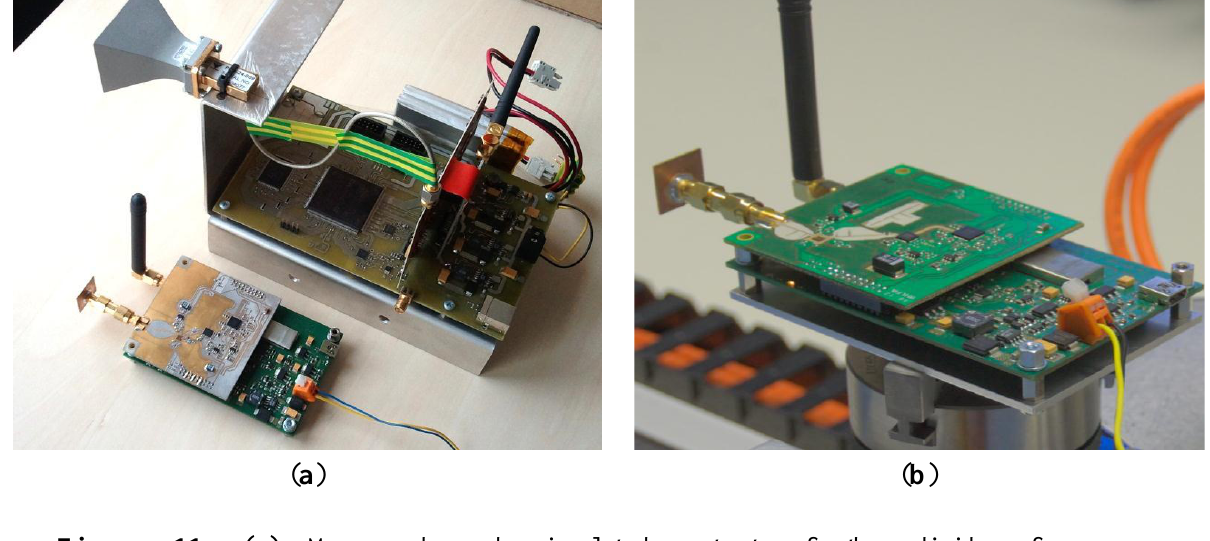
Figure 11. ( a ) Measured and simulated output of the divider frequency. ( b ) microphotograph of the integrated synthesizer